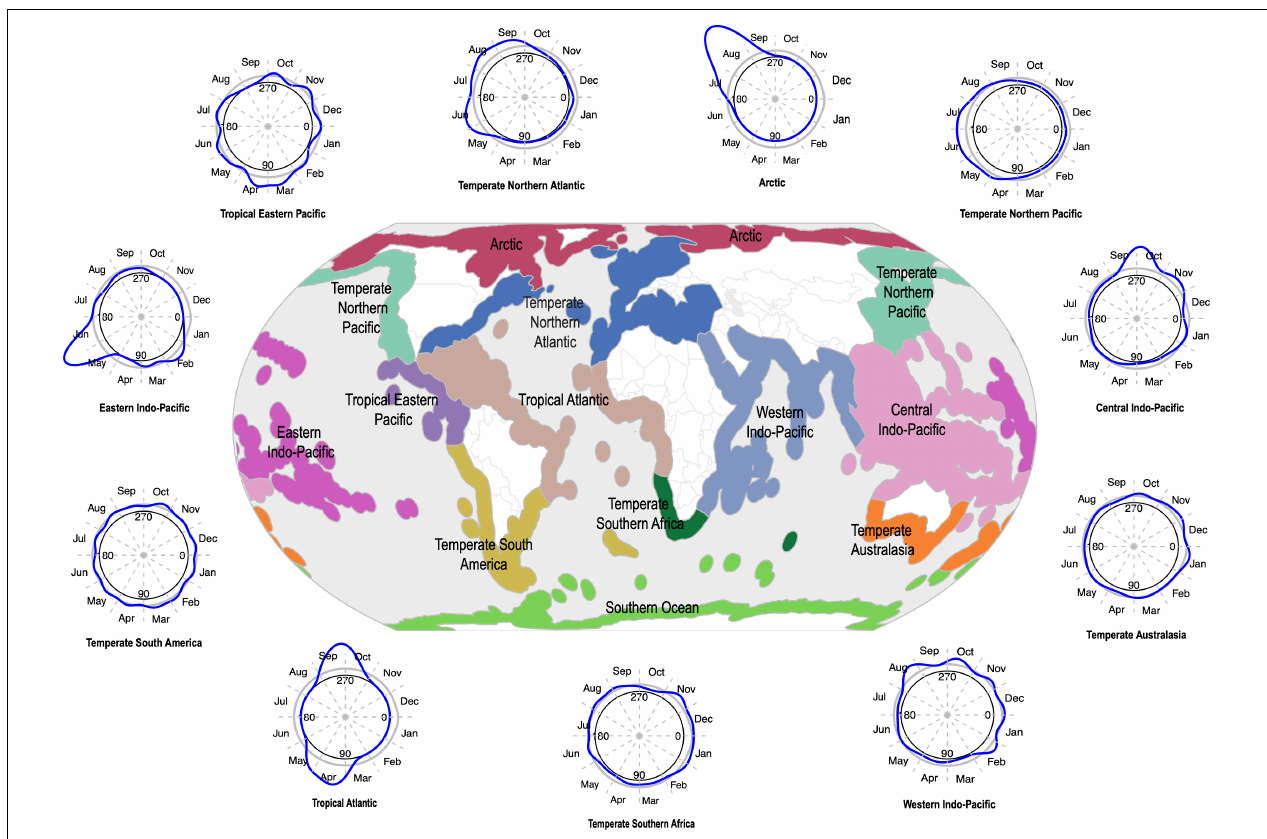
FIGURE 5 | Temporal trends in seagrass sampling are not consistent across seasons within marine ecoregions of the world (MEOWs). Temporal data from seagrass occurrence records were converted into Julian day of year format in order to analyze trends in the monthly sampling of seagrasses for all MEOWs. The blue line around each temporal sampling plot represents seagrass sampling density in monthly intervals over an extensive time period (1770–2019), with corresponding temporal sampling plot for each MEOW. Seagrass sampling rates increase during summer seasons associated with northern and southern hemispheres. The central plot provides a reference for the geographic location of each MEOW included in the analysis. Source data are provided as a Source Data